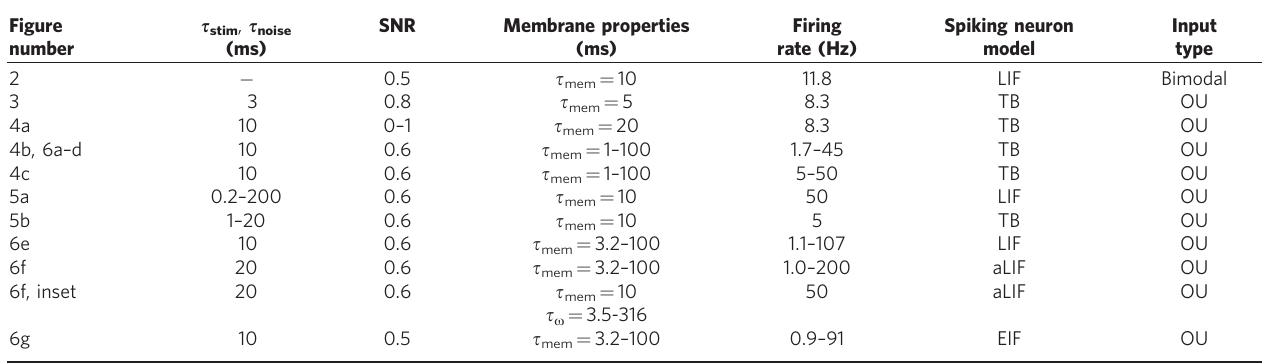
Table 1 | Parameter sets across neuron